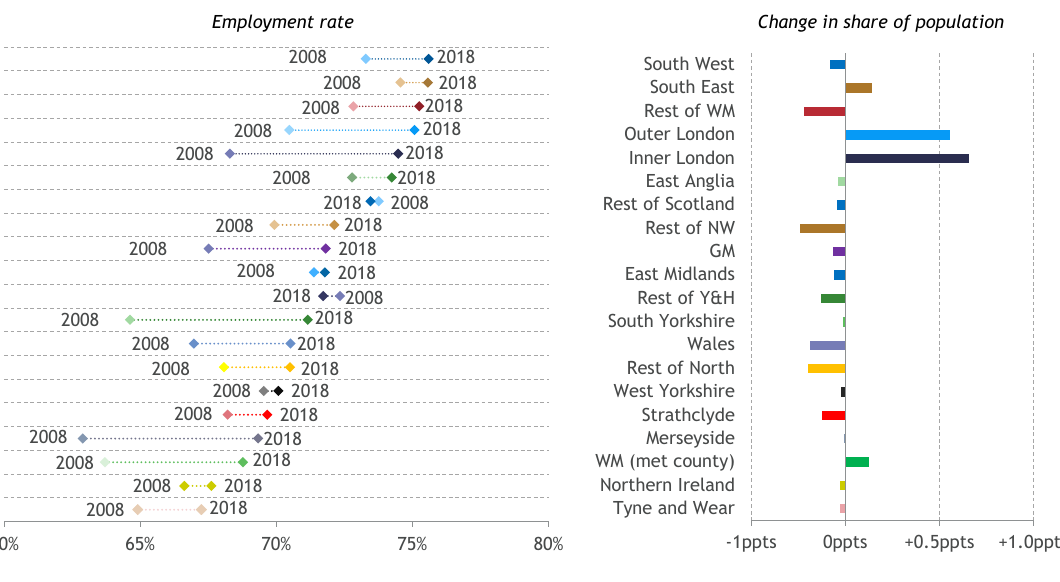
Figure 16: There was both a shift out of a low-employment regions and an improvement in the employment rates of parts of the UK with large